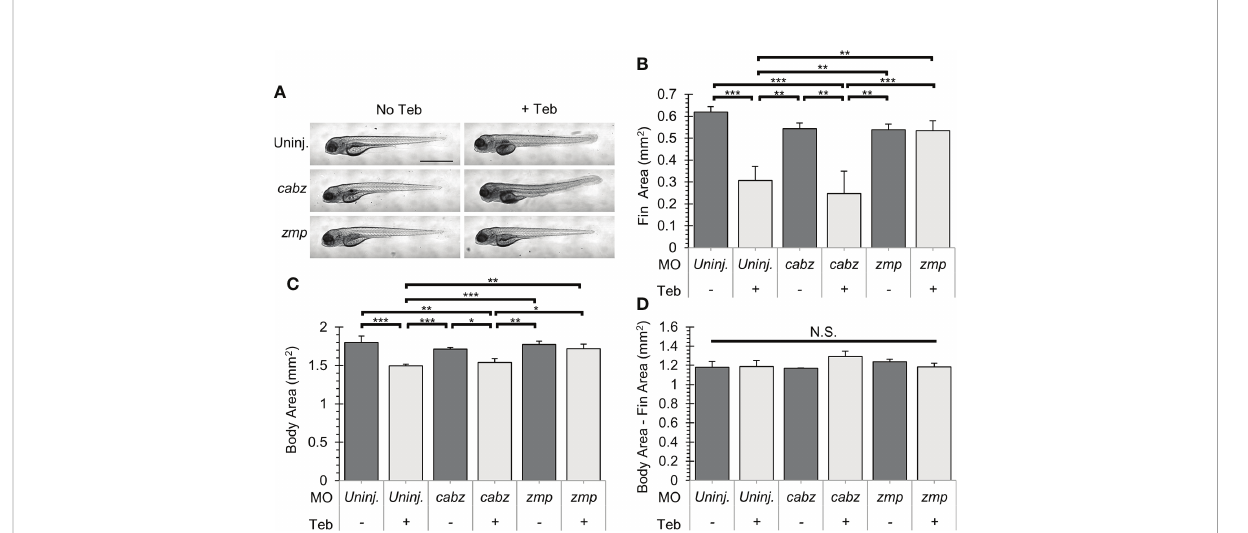
FIGURE 5 Gross morphological analysis of Il-1 b -induced morbidity. (A) Representative images of ubb:Gal4-EcR , uas:Il b mat larvae showing gross morphology. Shown here are uninjected larvae, cabz morphants, and zmp morphants without Teb (No Teb) and with Teb treatment (+Teb). Note that zmp morphants +Teb showed normal morphology with no gross defects. (B – D) Mean Cross-Sectional Fin Area (B) , Body Area (C) , and the product of Body Area – Fin Area (D) was plotted in mm 2 for each group. Error Bars are +1 standard deviation. Asterisks indicate signi fi cant differences *p < 0.05 **p < 0.01 ***p < 0.001; N.S., not signi fi cant; by one-way ANOVA followed by Tukey ’ s HSD Test. Scale bar in (A) is 1